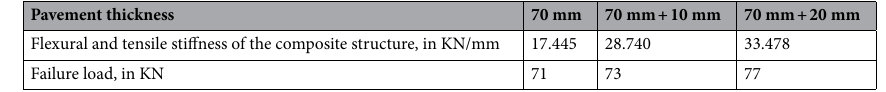
Table 5. Flexural and tensile stiffness and failure load of the composite structure formed by different thicknesses of double-layer pavement under the action of a positive bending moment.